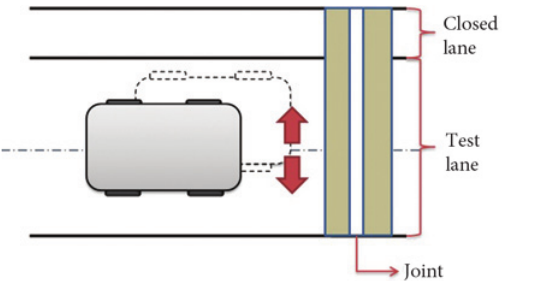
Fig. 15. Lane closure. Contractors are placing traffic cones to close the lane